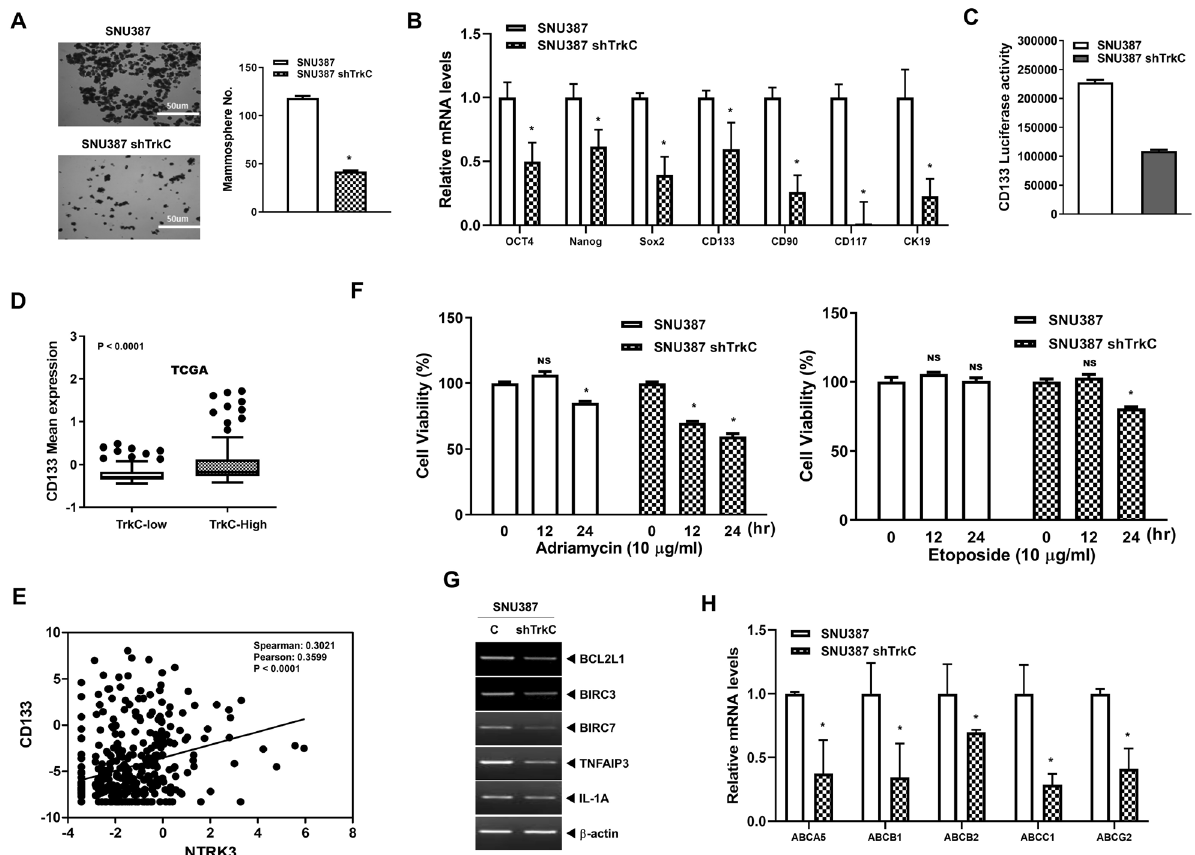
Fig. 5 Contribution of TrkC in the acquisition of cancer stem cells of HCC cells. A Phase-contrast images and quanti fi cation of spheroid formation of SNU387 control- or TrkC-shRNA cells. B Quantitative RT-PCR analysis of human embryonic stem (hES) cells markers (Oct4,